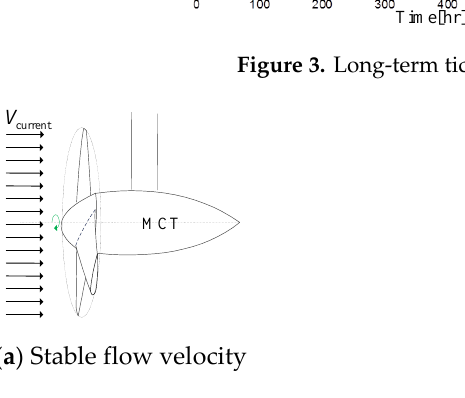
Figure 4. Spatial velocity change.